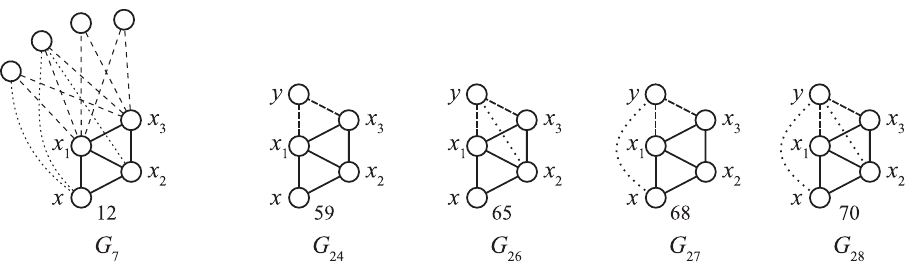
Fig 5. Extended graphlets with extra edges. Dashedlines represent edges requiredby condition y 2 N ( x 1 , x 3 ). Dotted lines represent possibleextra edges that make the resultinginducedgraph isomorphic to G 26 , G 68 or G 70 insteadof G 24 , with x in orbits o 65 , o 68 or o 70 insteadof o 59 ; these orbits appearon the left-hand side of Eq